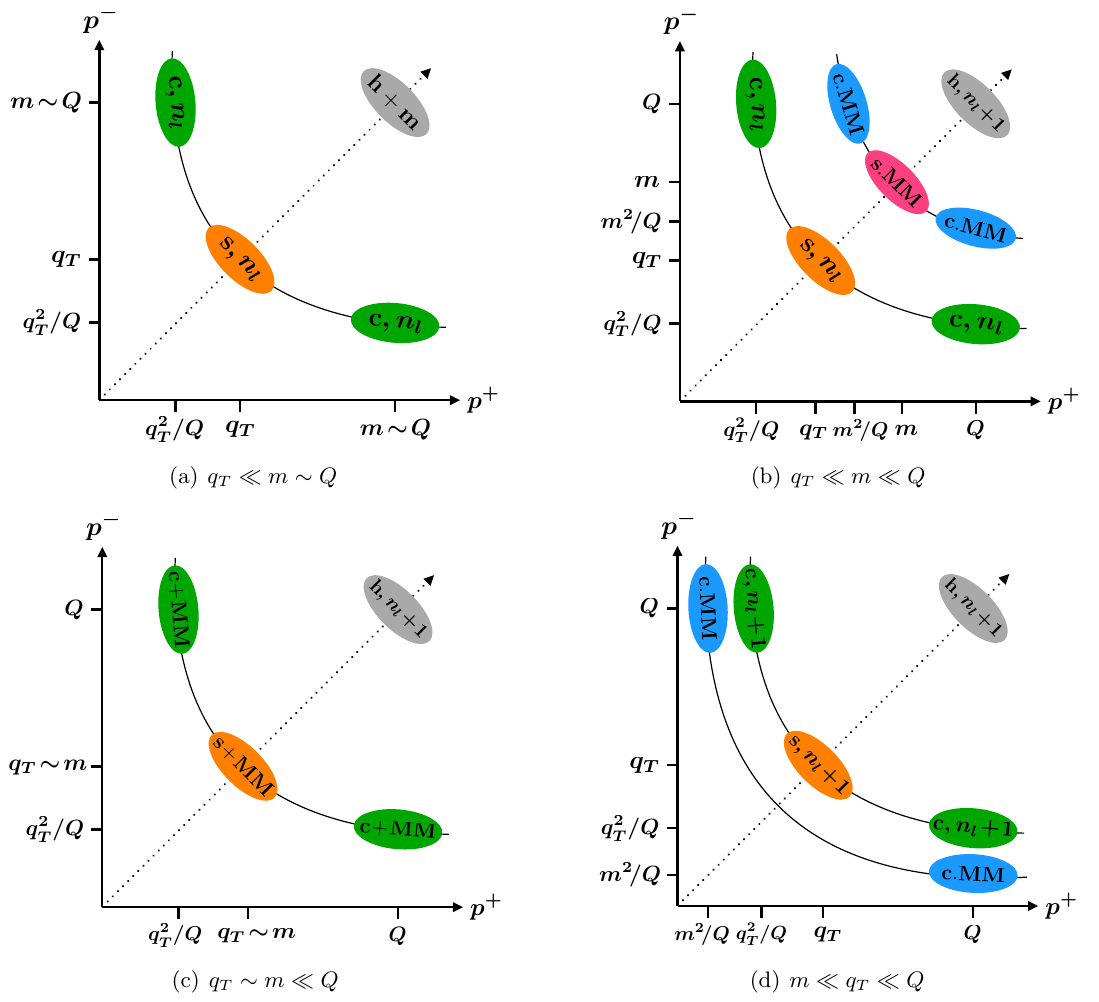
Figure 2 . E(cid:11)ective theory modes for the q T spectrum with massive quarks for q T m (cid:3) QCD (cid:29)